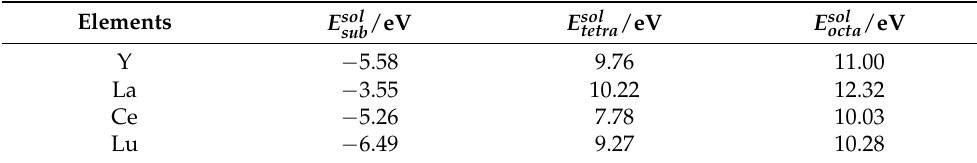
Table 3. Solution energies of single M atom in bcc tungsten for different sites calculated in VASP.